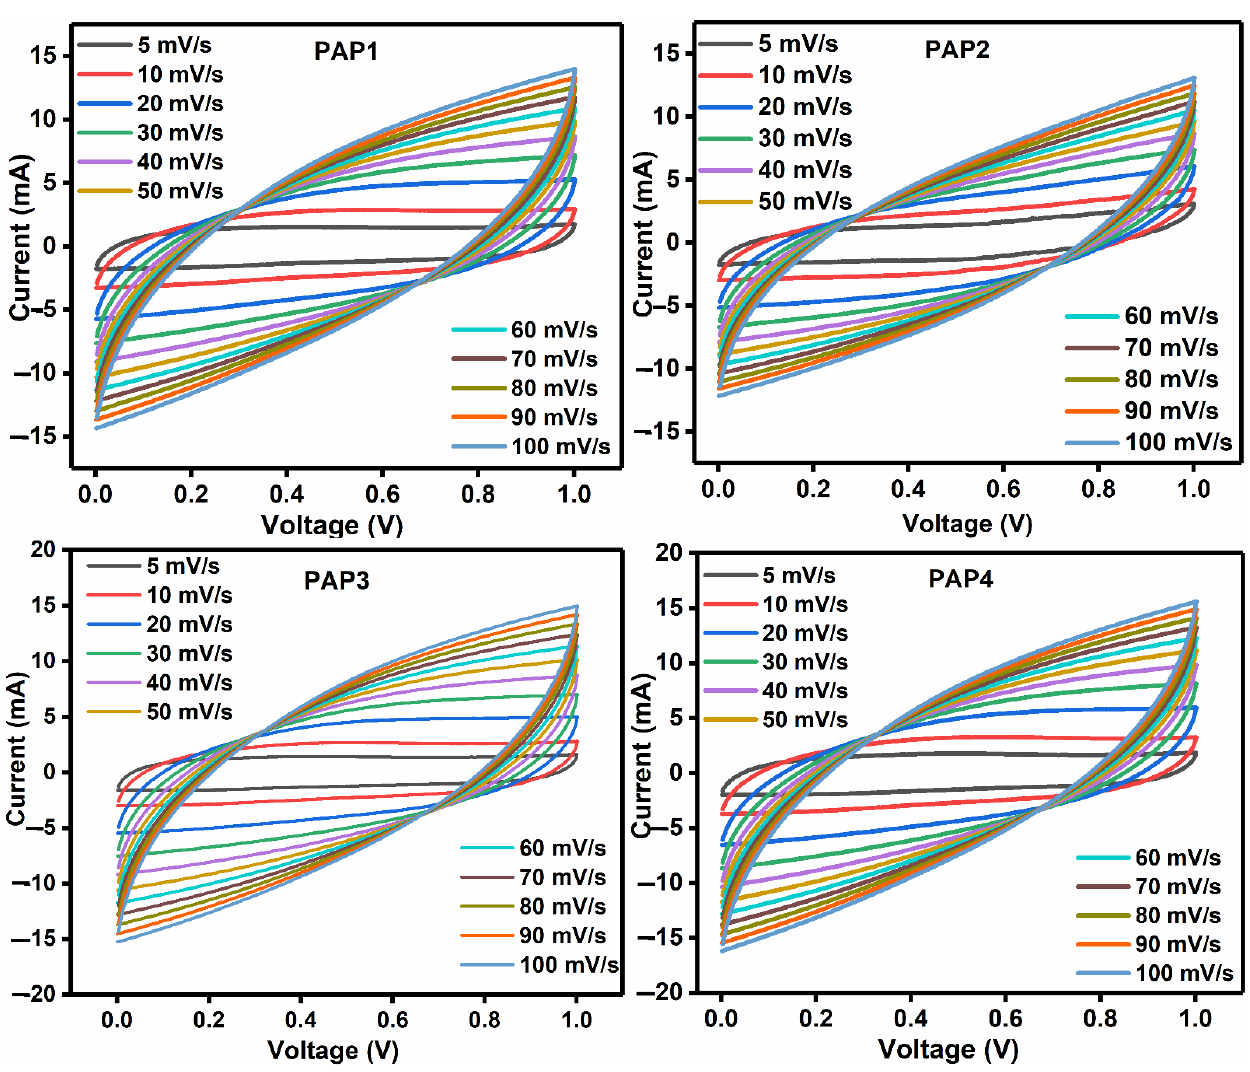
Figure 10. CV curves of all samples at different scan